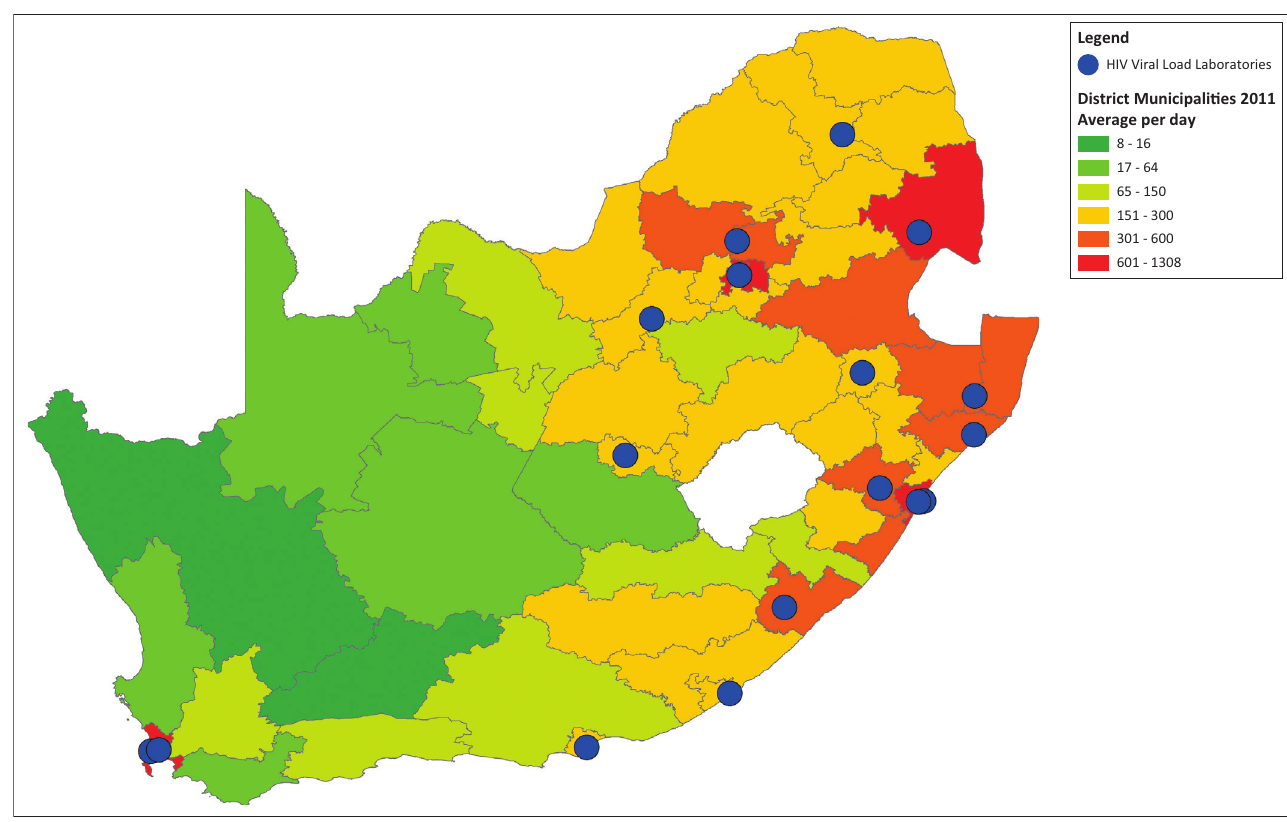
FIGURE 2: Current daily HIV viral load test volumes per day per health district with the laboratories offering testing ( n =17), South Africa.